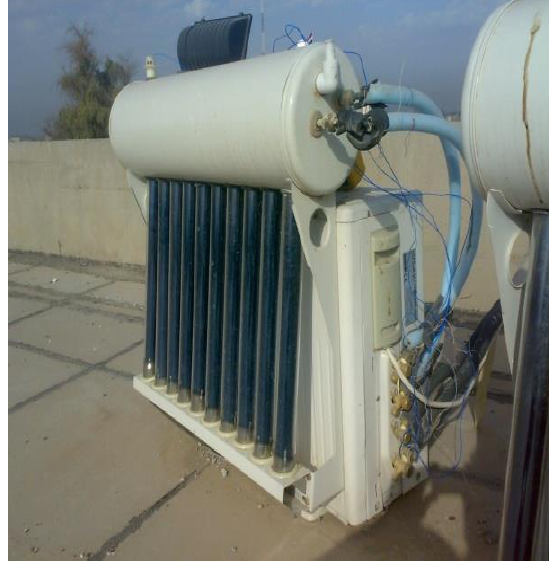
Fig.8: Description connects of hybrid solar